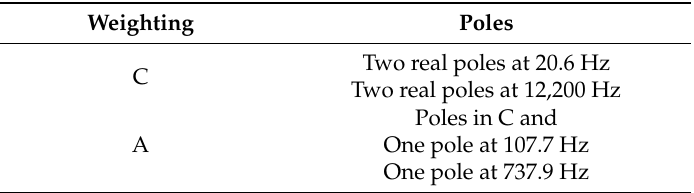
Table 1. Poles used to design the analog filters.